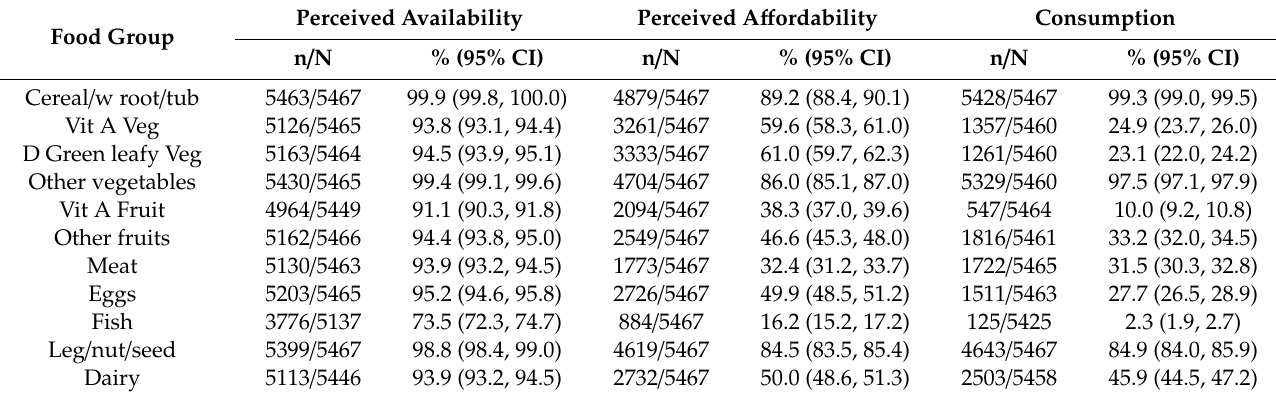
Table 2. Perceived availability, a ff ordability and consumption of family foods in Addis Ababa,